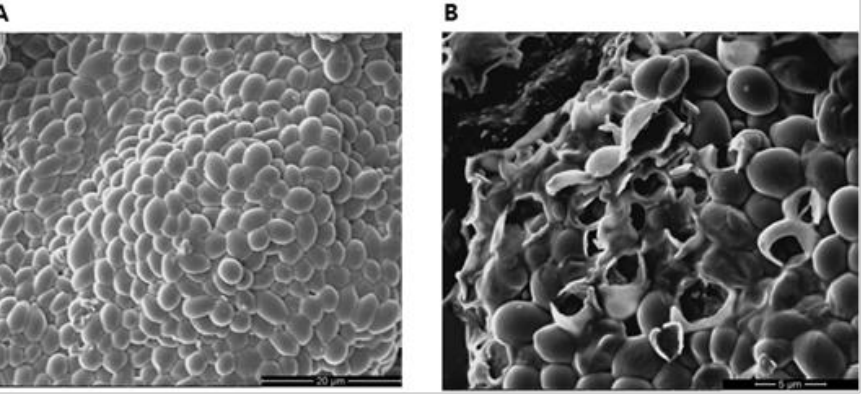
Figure 1. Scanning electron microscopy images of C. curvatus cells. ( A ) Before lipid extraction (5000×) and ( B ) after lipid extraction (10,000×).